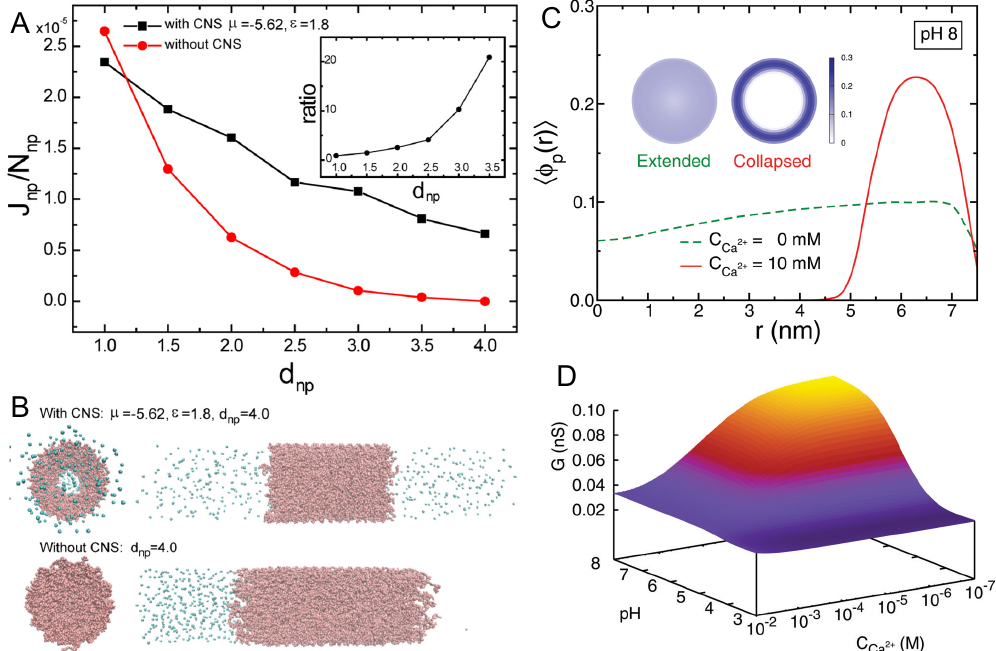
Figure 9. Gating of homopolymer-coated nanopores. ( A ) Stationary fluxes of nanoparticles as a function of the diameter of the NP in open (black squares) and closed (red circles) states controlled by the co-nonsolvent. The ratio of the fluxes is shown in the inset. ( B ) Morphologies of open (upper) and closed (lower) states in MD simulations, with red and green beads representing monomers and NPs, respectively. Reprinted with permission from the authors of [170]. ( C ) Profile of polymer volume fraction as a function of the distance r from the center of the channel, in extended (green) and collapsed (red) states. ( D ) A typical landscape of conductance as a function of pH and calcium concentration. (Reprinted with permission from the authors of